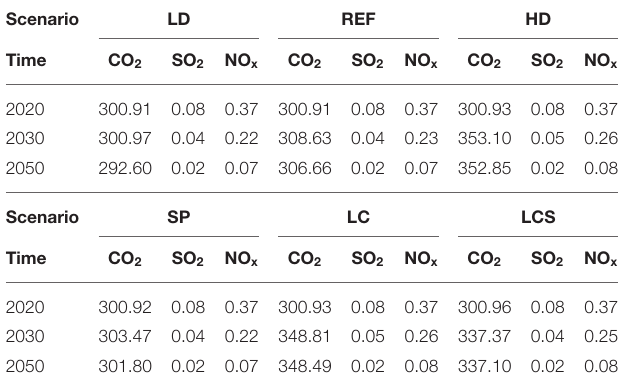
FIGURE 6 | The EPP capacity in 2050.